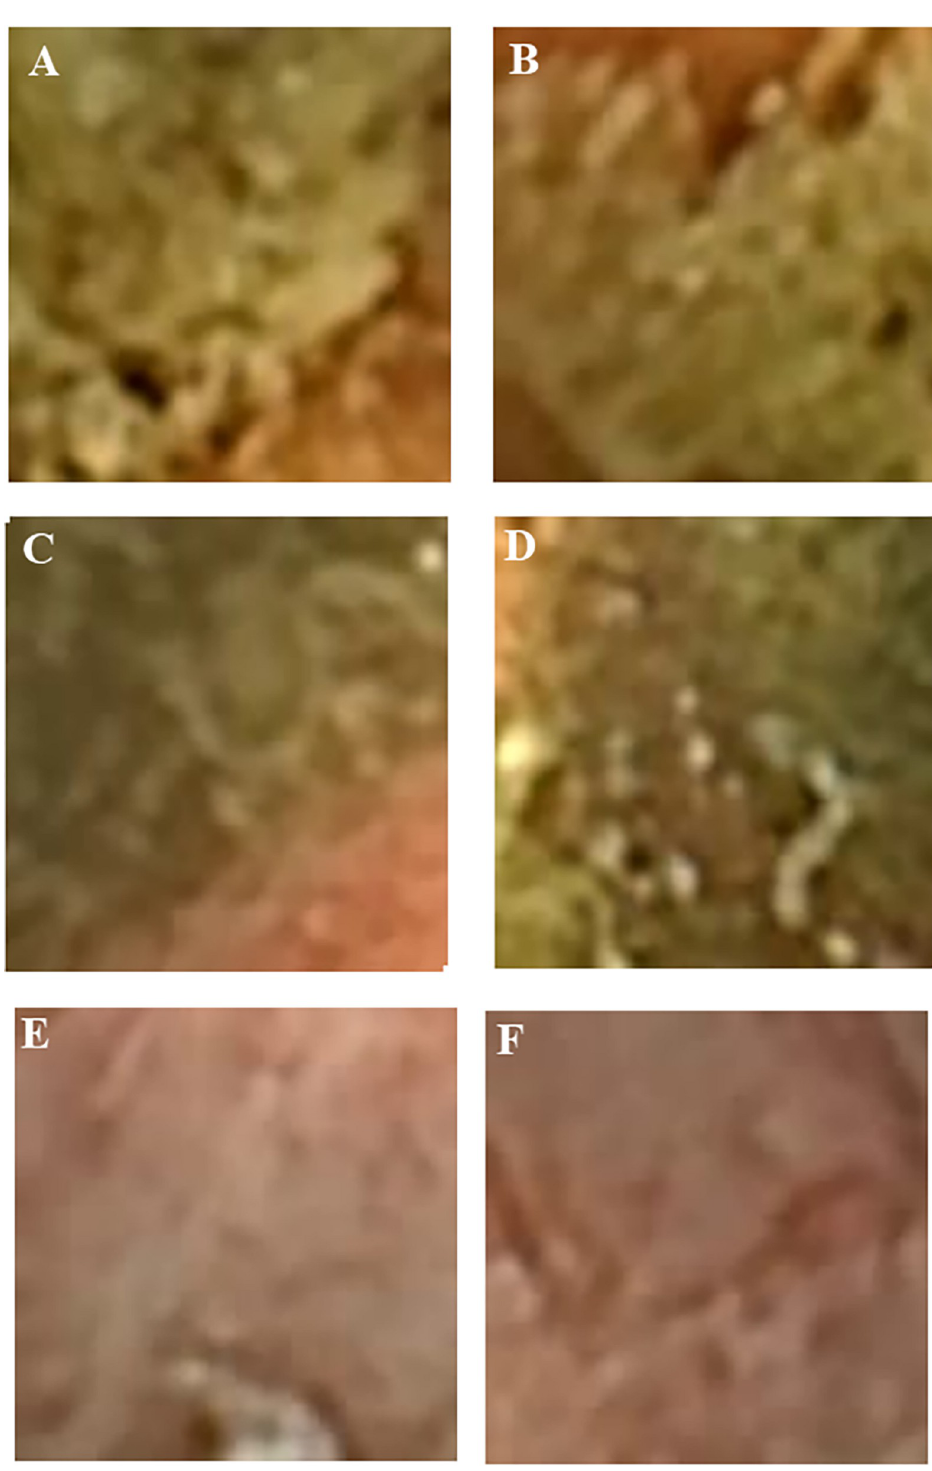
Fig 4. Training images of ulceration. A and B, examples for training images of ulceration with exudate labeled as MES3; C and D, examples for training images with opaque residue labeled as inadequate quality for evaluation which were not discriminated from A and B; E and F, examples for validation images with minor ulceration labeled as MES3, which were misclassified as white scar or MES0.